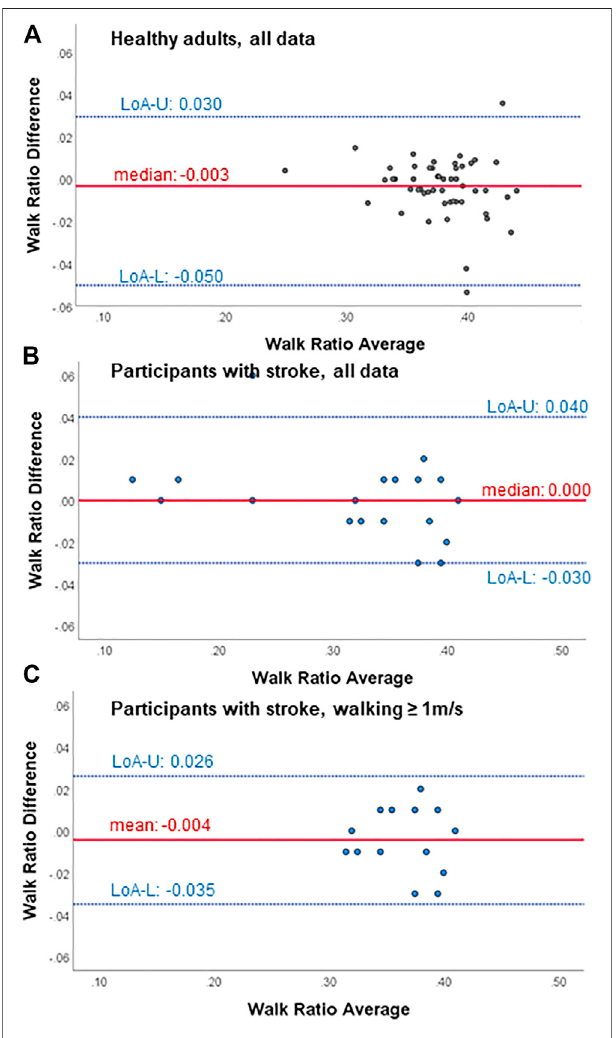
FIGURE 1 | Bland-Altman plots for test-retest agreement of the walk ratiomeasuresfromthewearable-basedoutdoorwalkratioassessmentin (A) healthyparticipants ( n =51), (B) all participant withchronic stroke ( n = 19)and (C) participants with chronic stroke walking ≥ 1 m/s ( n = 14). Diff, difference; LoA-U, upper limit of agreement; LoA-L, lower limit of agreement.